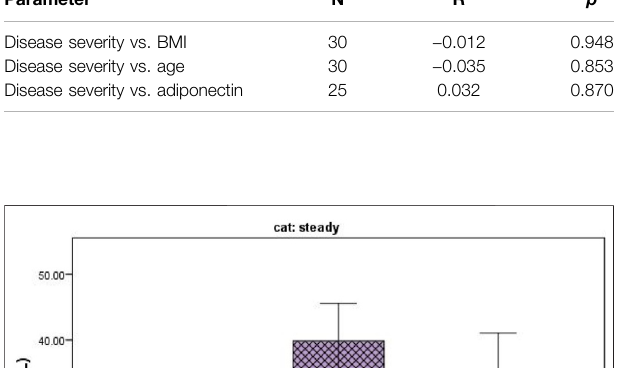
TABLE 3 | Correlation studies of BMI, age, and adiponectin levels with disease severity in subjects with sickle cell anemia in the steady state. Parameter